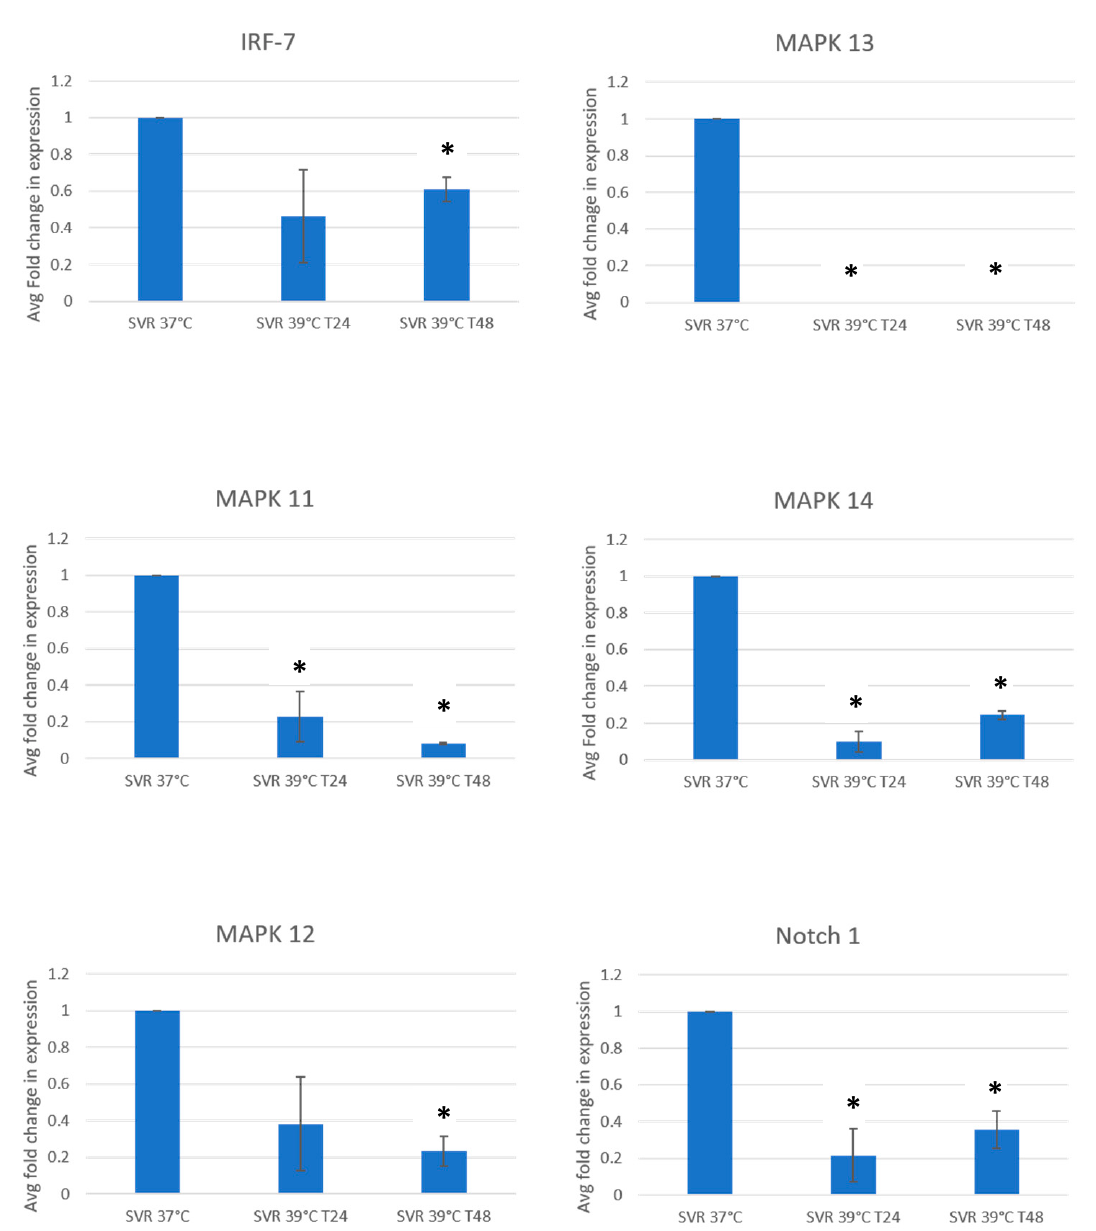
Figure 1. qPCR SVR cells under 37 °C and 39 °C (in 24 and 48 h) for evaluating Notch1, IRF-7, and p38 MAPK kinases. Experiments were repeated in threefold, and decreases were significant at p = 0.05 at 48 h marked by an asterisk (*).